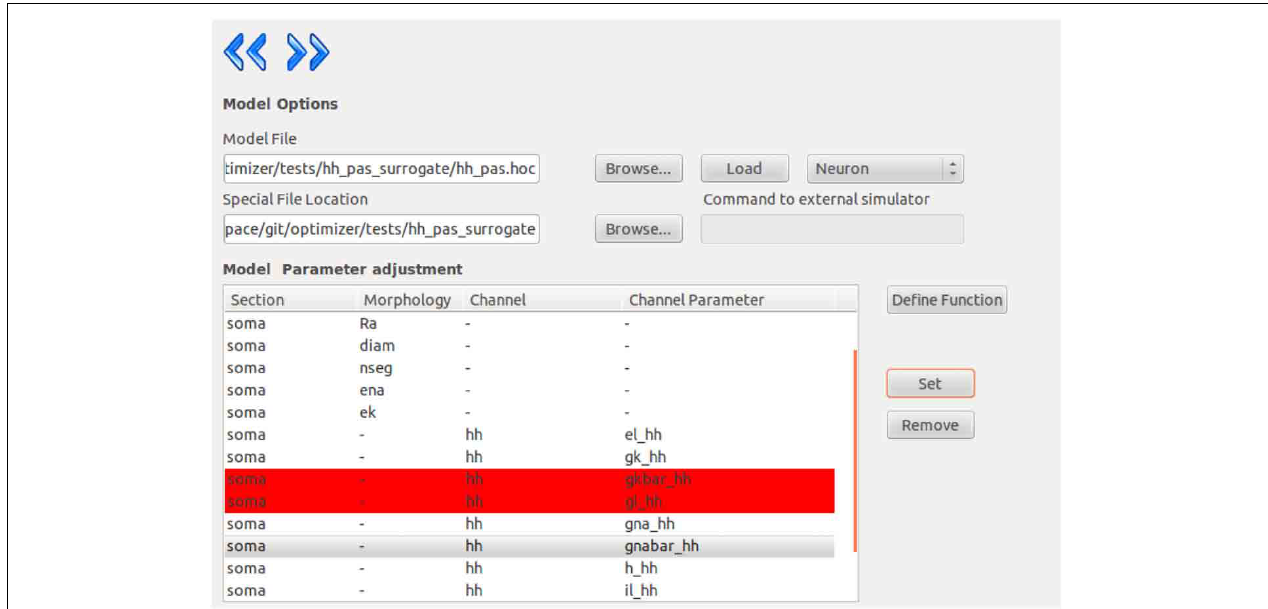
FIGURE 2 | Screenshot from the Optimizer GUI, showing the model selection and parameter selection